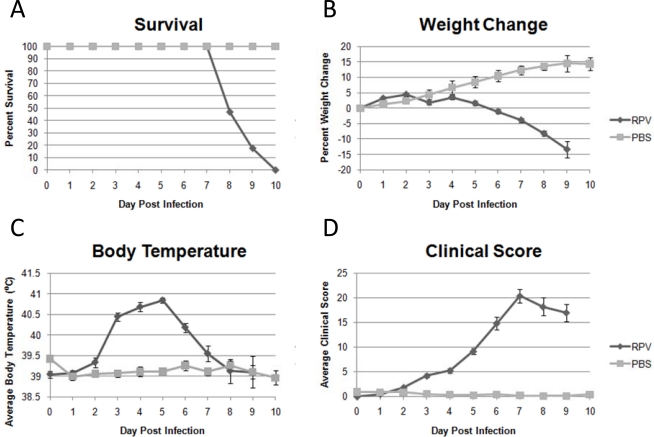
Disease in rabbits lethally infected with RPV compared to age/weight matched mock infected rabbits. (A) Survival; (B) Average weight change from weight at time of infection for each group. Negative values represent weight loss. (C) Average body temperatures over time. Temperatures over 39.5 °C are considered a fever. (D) Average clinical score over time. Error bars represent SEM. Reproduced with permission from American Society for Microbiology [19].